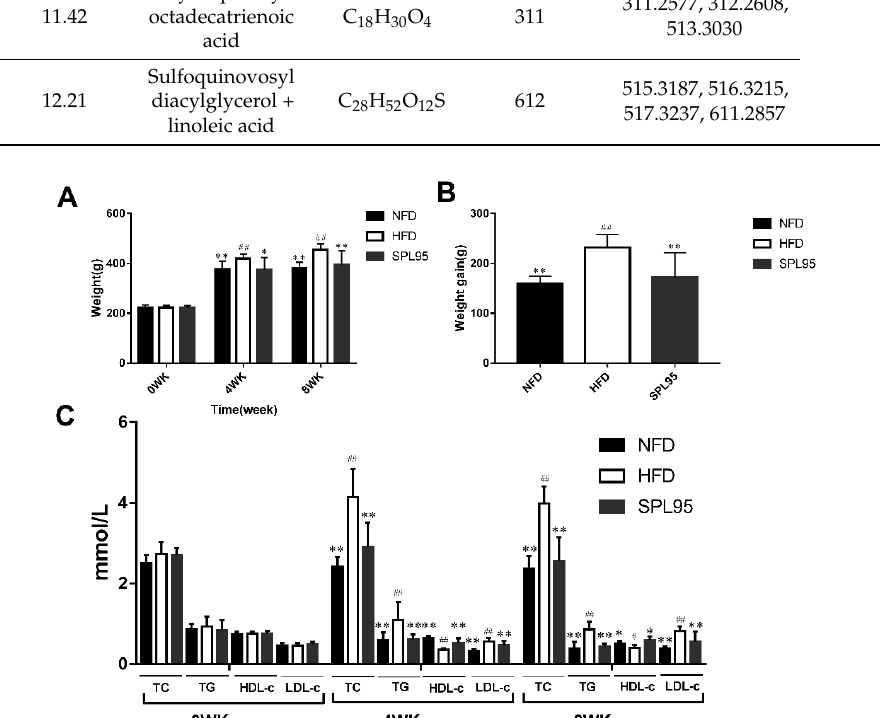
Figure 1. Effect of SPL95 on body weights ( A ), body weight gain ( B ), and serum lipid parameters ( C ) of high-fat-diet rats during the experimental period. NFD: Normal fat diet; HFD: High-fat diet; SPL95: 150 mg/(kg·day) S. platensis 95% ethanol extract; WK: Week. NFD group, rats fed NFD and gavaged with 150 mg/(kg·day) normal saline. HFD group, rats fed HFD and gavaged with 150 mg/(kg·day) normal saline. SPL95 group, rats fed HFD and gavaged with 150 mg/(kg · day) SPL95. Data are expressed as mean ± SD ( n = 8). # p < 0.05 and ## p < 0.01, compared with NFD group; * p <0.05 and ** p < 0.01, compared with HFD group. TG, triglyceride; TC, total cholesterol; HDL-c, high-density-lipoprotein cholesterol; LDL-c, low-density-lipoprotein